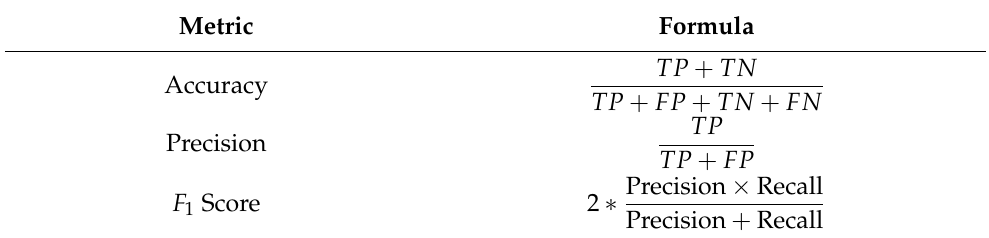
Table 3. Metrics and formulas used to measure model performance.